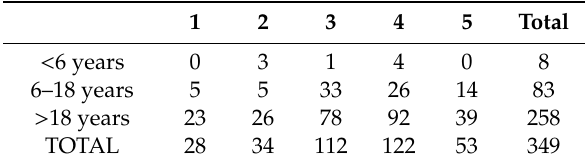
Table 3. Assessment of experience in Open Access publishing (1 to 5) according to years of experience.